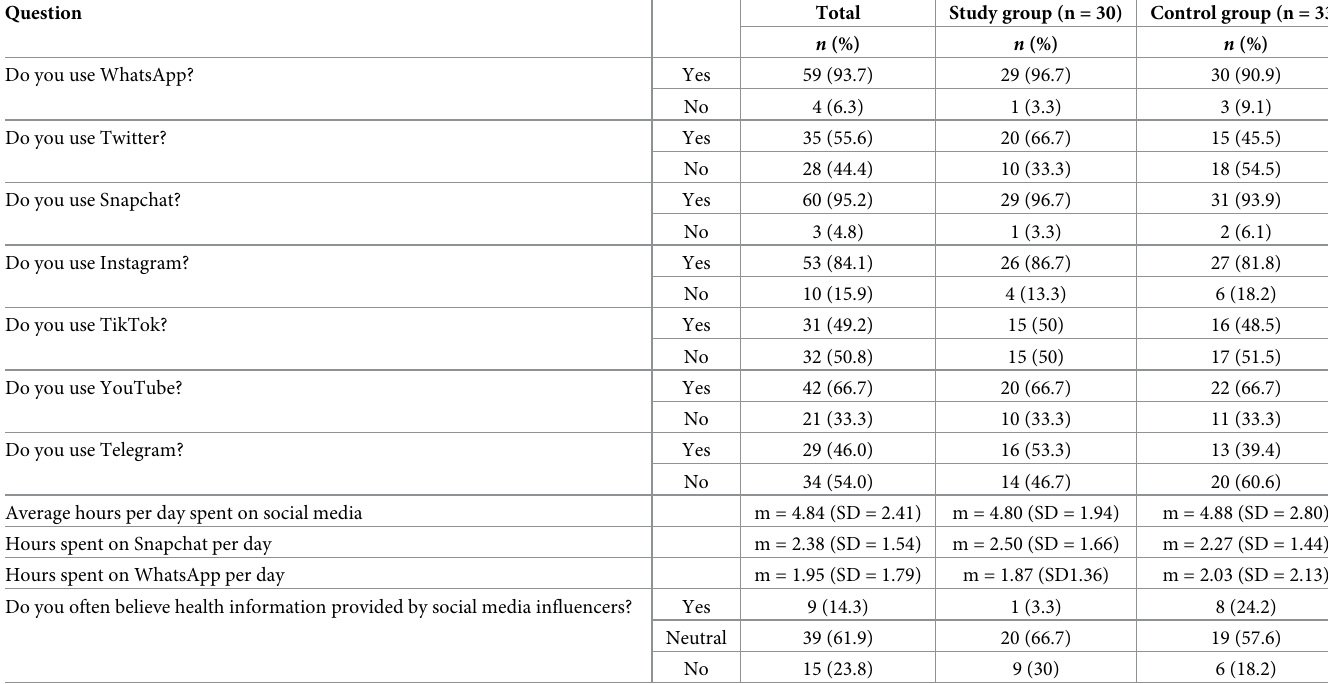
Table 3. Frequency of using social media by pregnant women in Saudi Arabia in the current study.